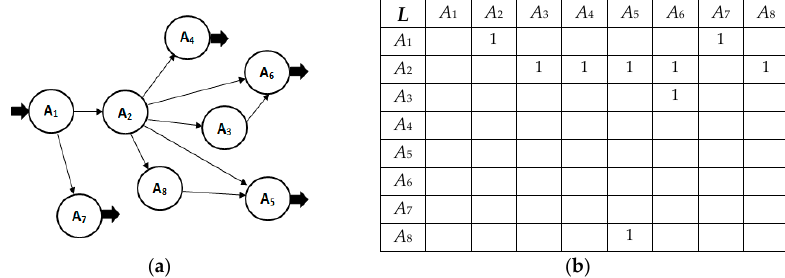
Figure 3. Mathematical formalization of the investigated object Ω O ( a ) graph scheme of algorithm (GSA), ( b ) matrix of connections (conceptual